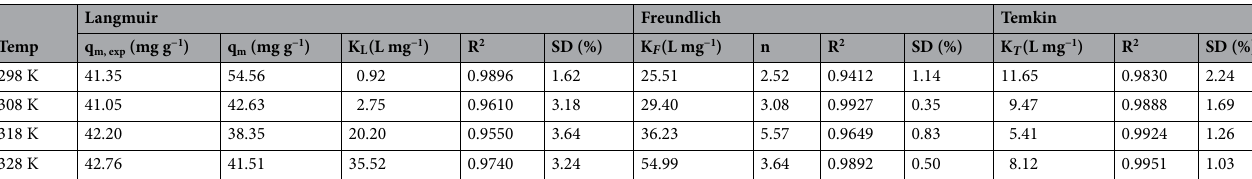
Table 4. Parameters of Adsorption Isotherms including Langmuir, Freundlich and Temkin Models for Pt(IV) on Tu–N–SCG–C–A.